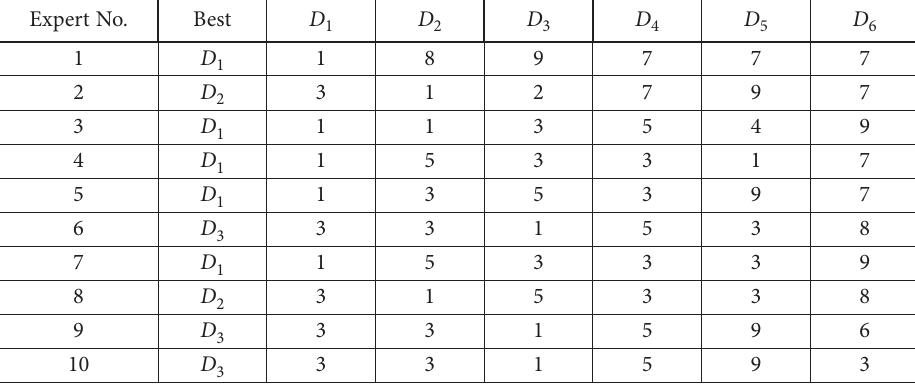
Table 6. OW dimension vectors for the 10 experts Expert No.